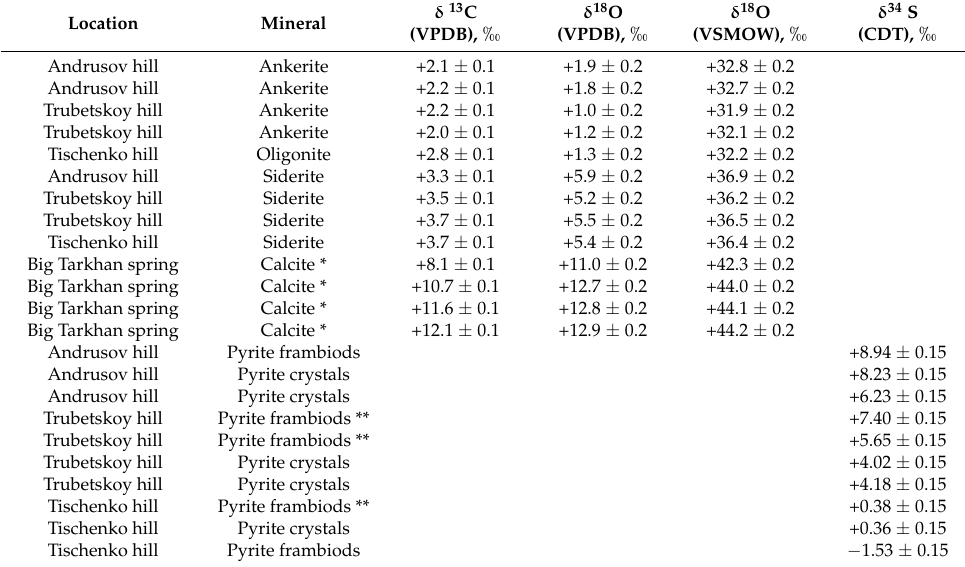
Table 5. Isotope composition of authigenic carbonates and pyrite from mud masses (Bulganak MV areas) in comparison with Big Tarkhan